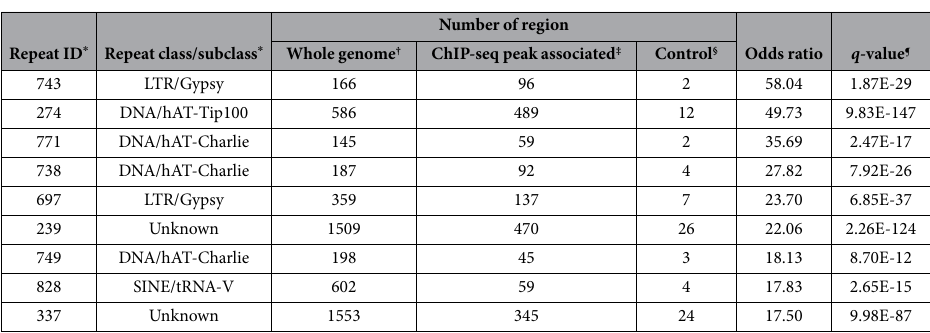
Table 3. Association of CTCF binding with repetitive elements. * See Materials and Methods, for repeat identification and (sub)class assignment. † Total number of individual repeat regions in the whole genome identified by RepeatMasker. ‡ Number of repeat regions overlapping with ChIP-seq peaks (summit ± 50 bp). § Number of repeat regions overlapping with control regions (50,000 regions of 100 bp each). ¶ p -values from Fisher’s exact test subjected to multiple correction by the Q-value package in